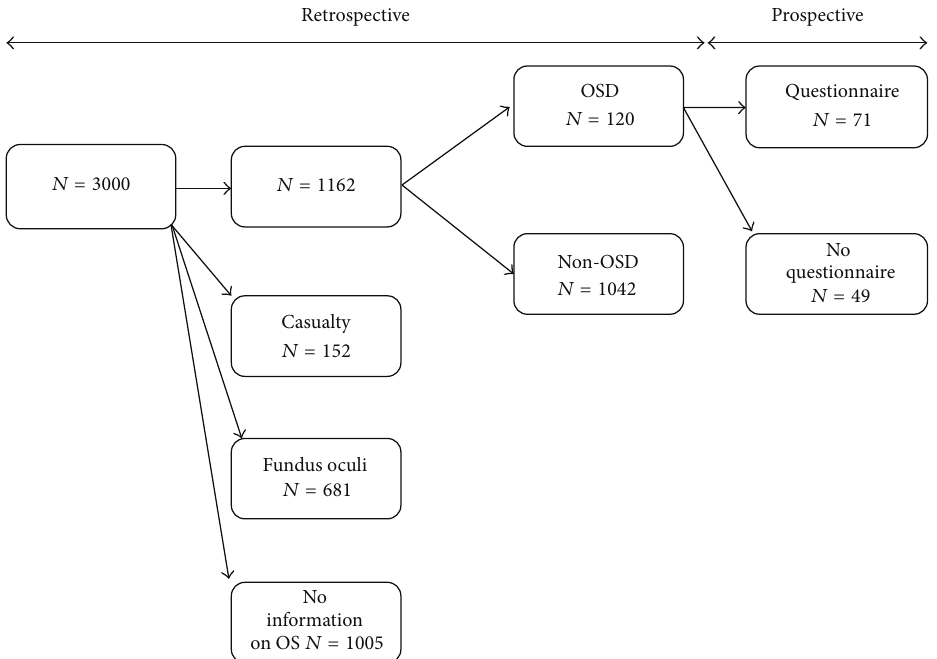
Figure 1: Flow chart of the events of the study.